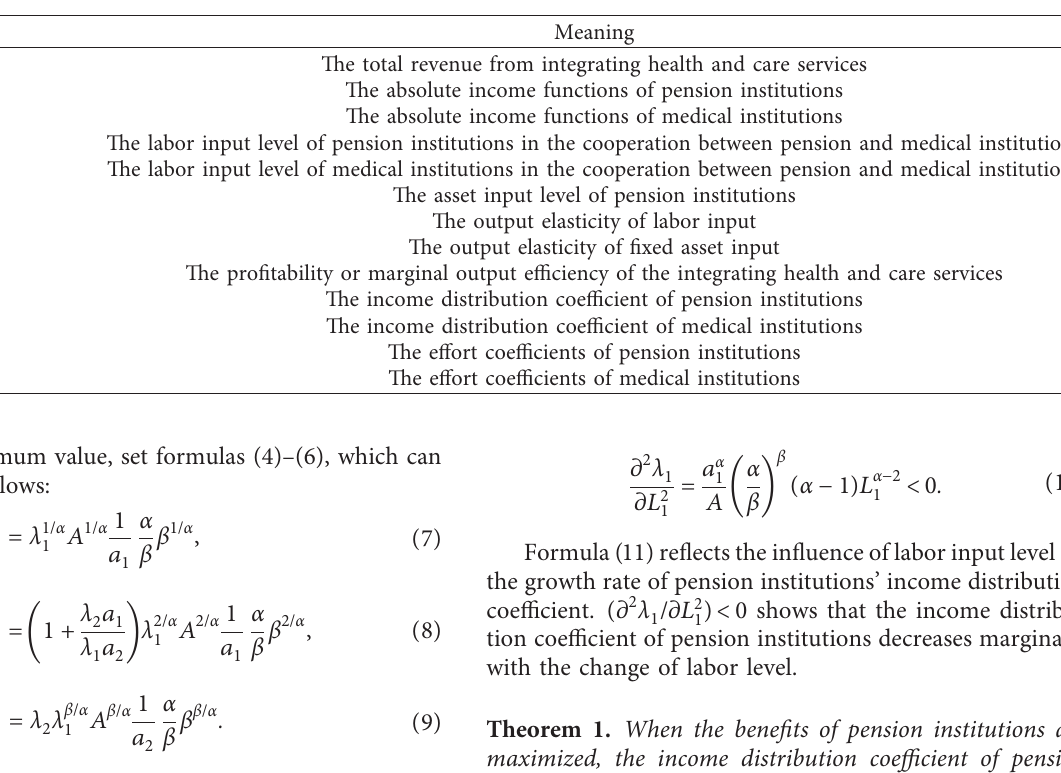
Table 1: Variables and